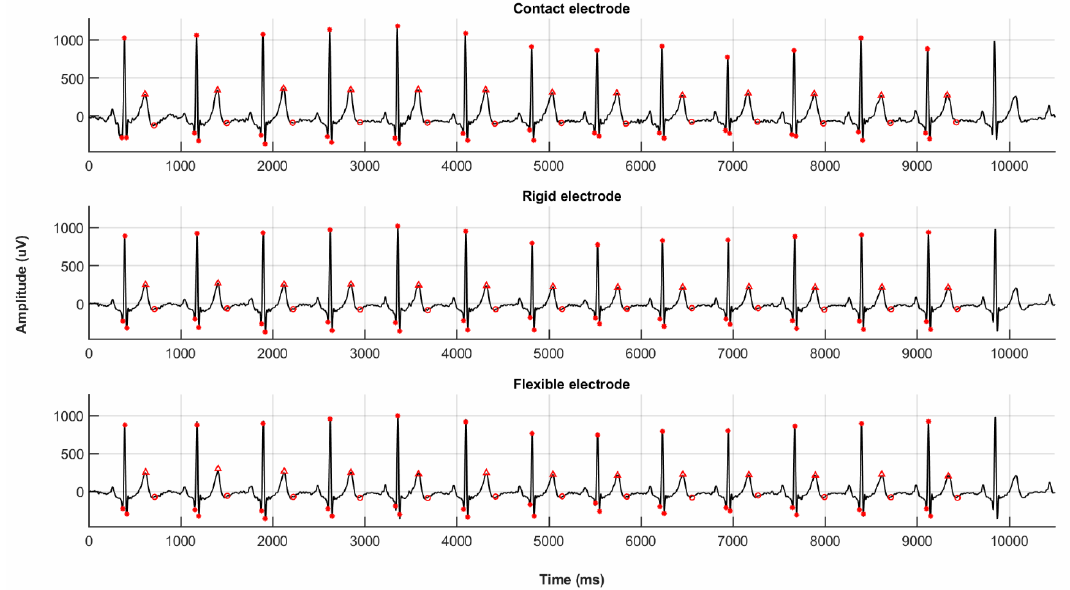
Figure 10. ECG spectra obtained simultaneously for these three acquisition methods: ( top ) Contact electrode. ( middle ) Rigid electrode. ( bottom ) Hybrid flexible